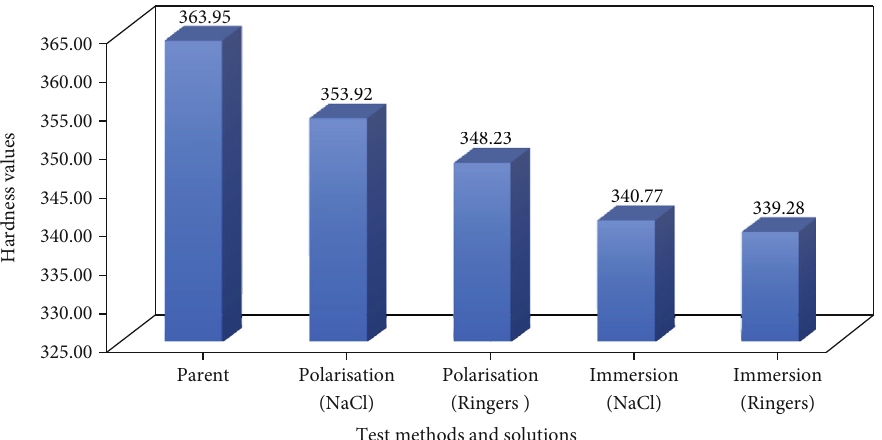
Figure 2: Hardness results before and after corrosion testing.